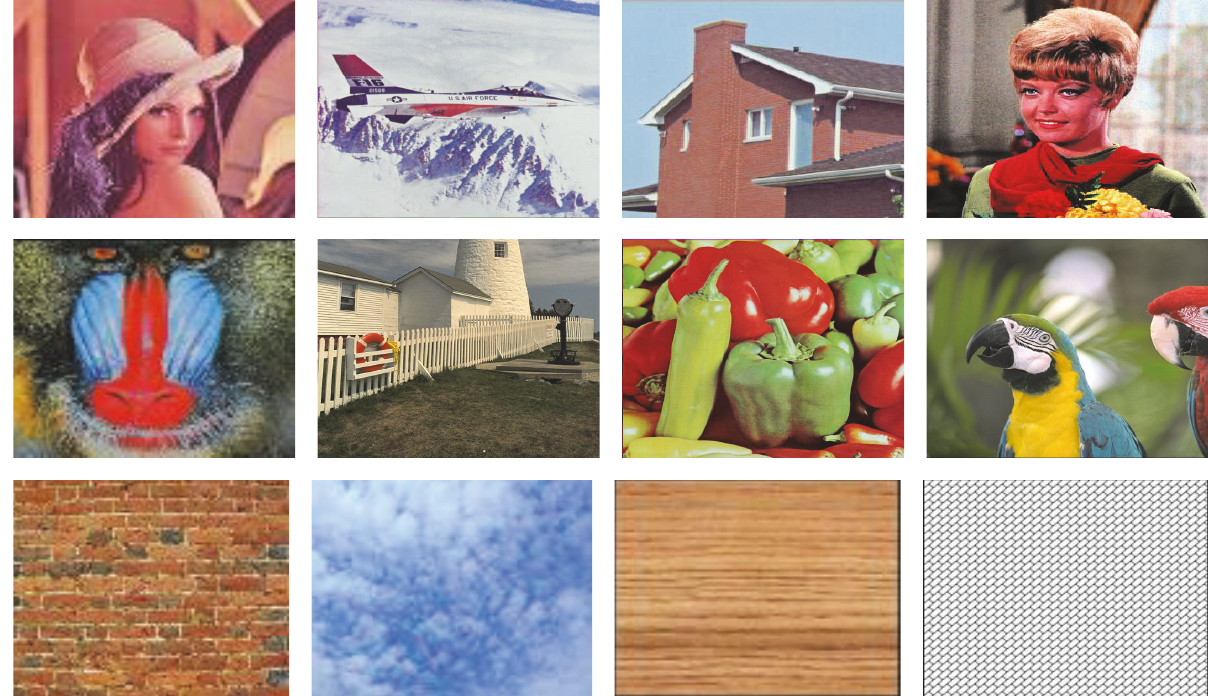
Figure 4: Test image: Images 1–12 (from left to right, top to bottom).